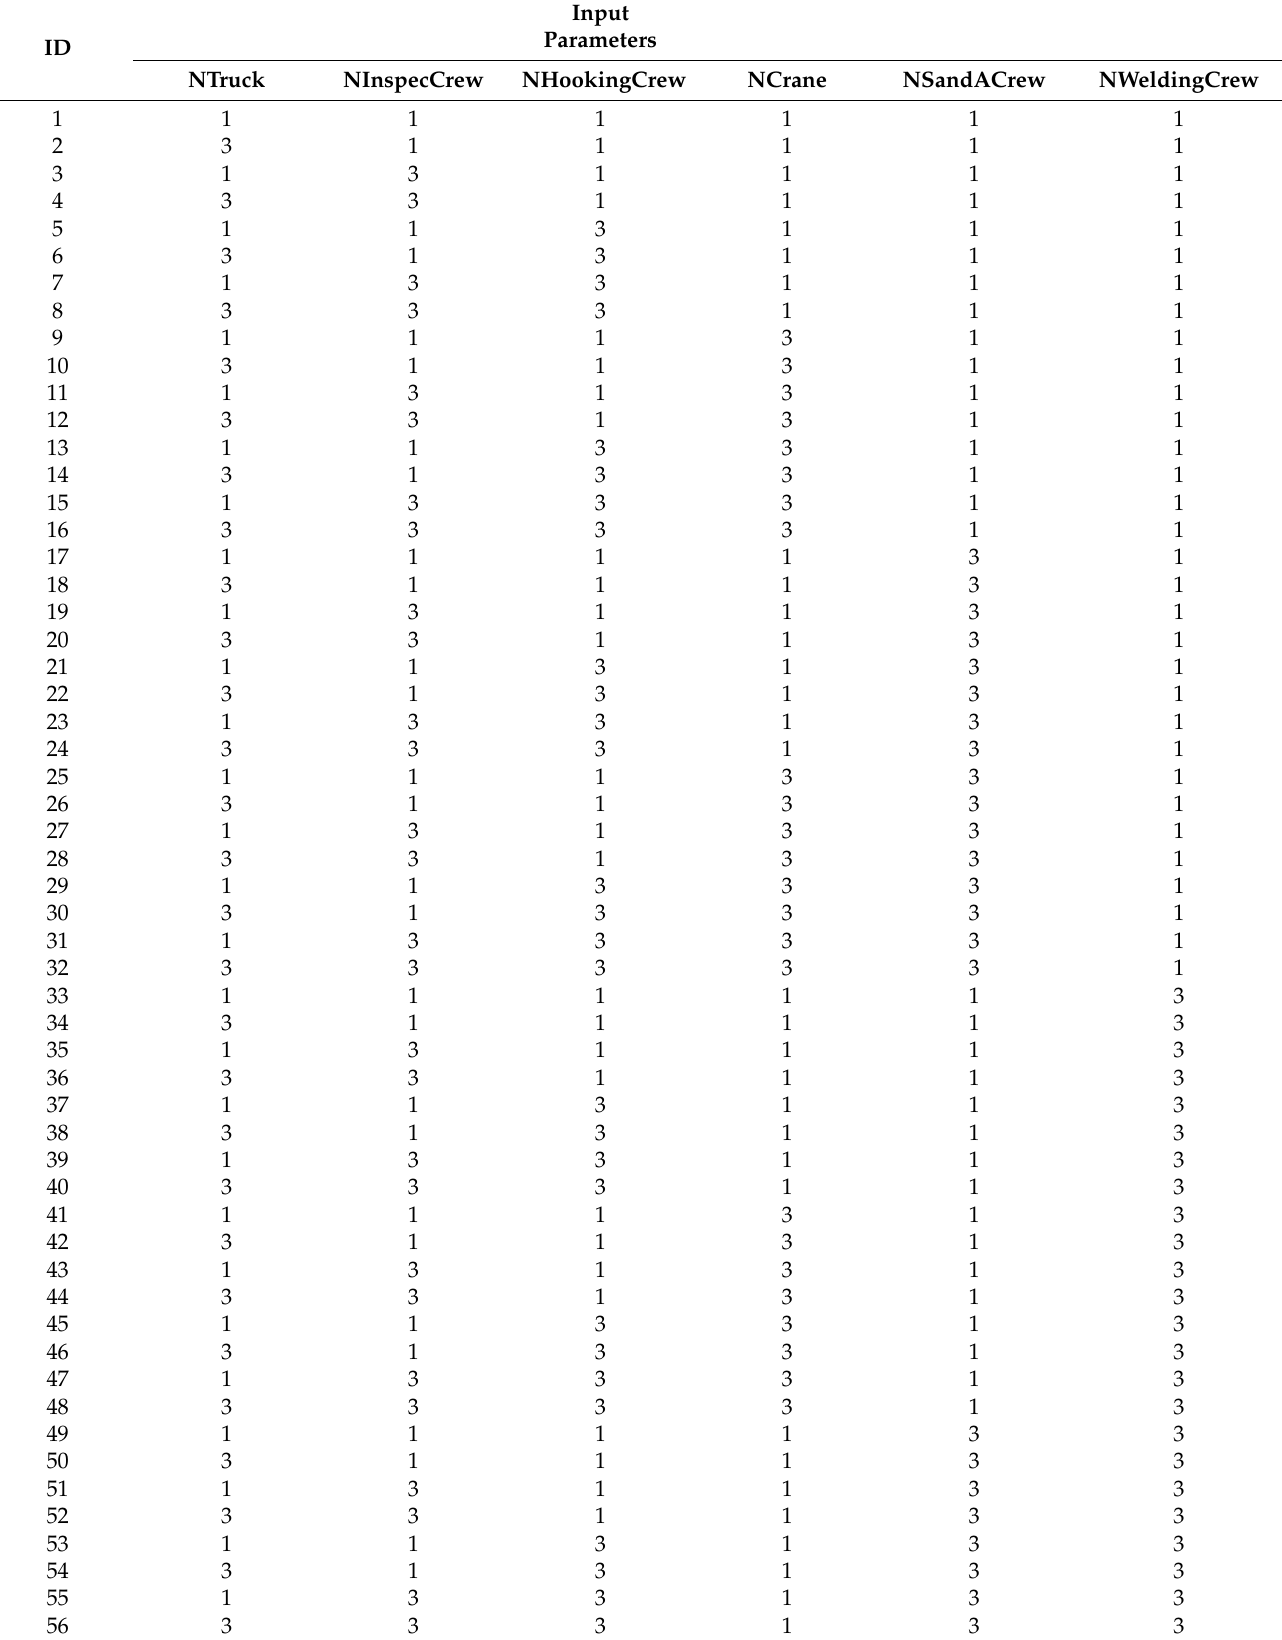
Table 5. A total of 64 experiments of full factorial design for identified input